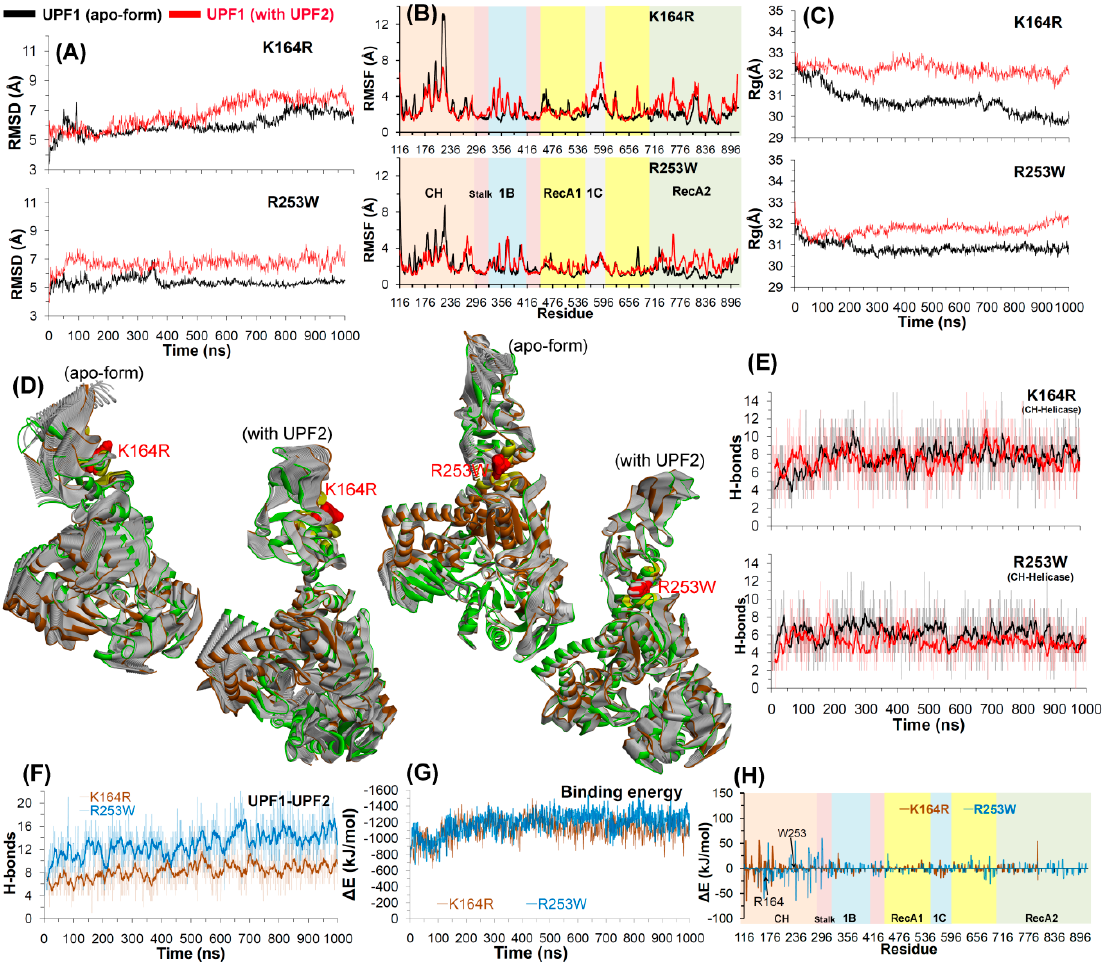
Figure 6. Structural analysis of UPF1 mutants K164R and R253W. ( A – C ) RMSD, RMSF, and radius of gyration profiles representing structural changes and fluctuations of UPF1 residues. ( D ) The motion corresponding to the first eigenvector defined on the basis of the combined trajectories. ( E , F ) Number of hydrogen bonds formed between CH-helicase domains (UPF1 intramolecular interactions) and between UPF1-UPF2 (intermolecular interactions). The dark lines represent trend with a moving average of H-bonds formed with a period of 10 ns (i.e., number of H-bonds averaged every 10 ns). ( G , H ) Energy of each residue (of the mutant UPF1) contributing to the binding with UPF2 and total binding energy for UPF1-UPF2, calculated by MM-PBSA.